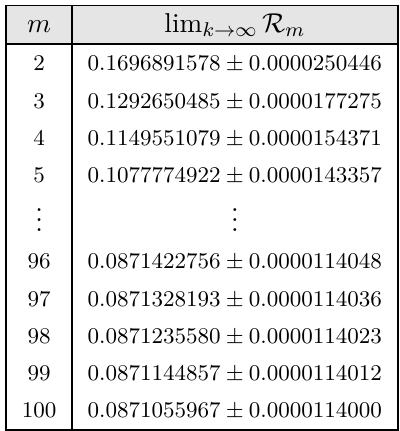
Figure 9. Variation of Rényi entropies for the state | 5 1 # T 2 , 2 i with k .